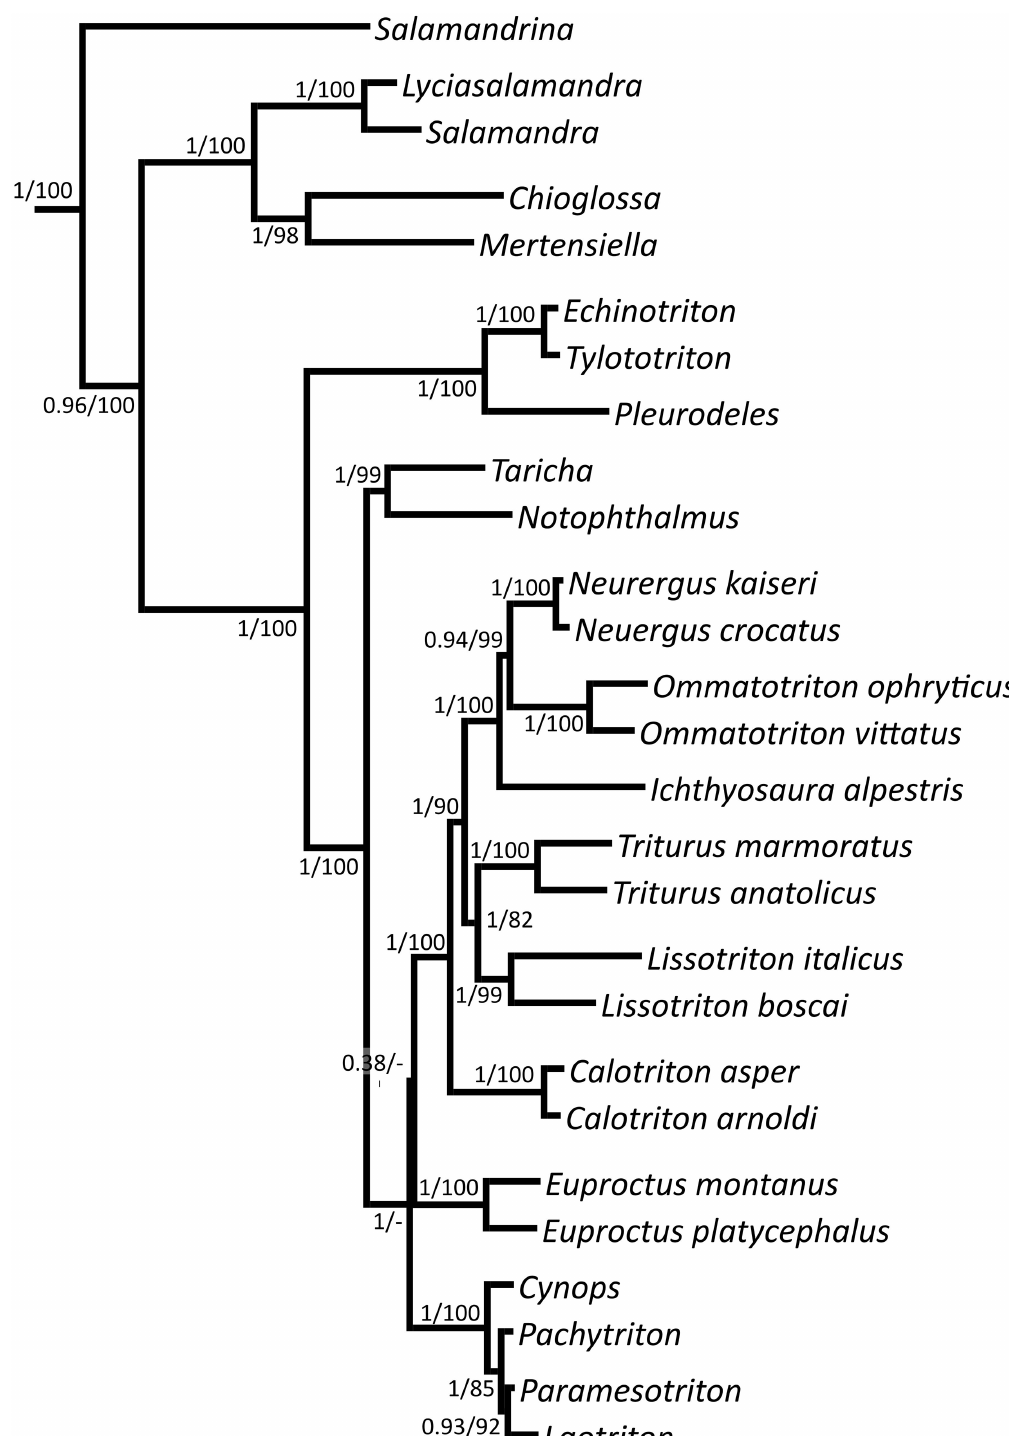
Fig 1. Bayesian tree of Salamandridae based on four nuclear genes. Bayesian posterior probabilities/bootstrap support values for the maximum likelihood tree are given at the nodes.